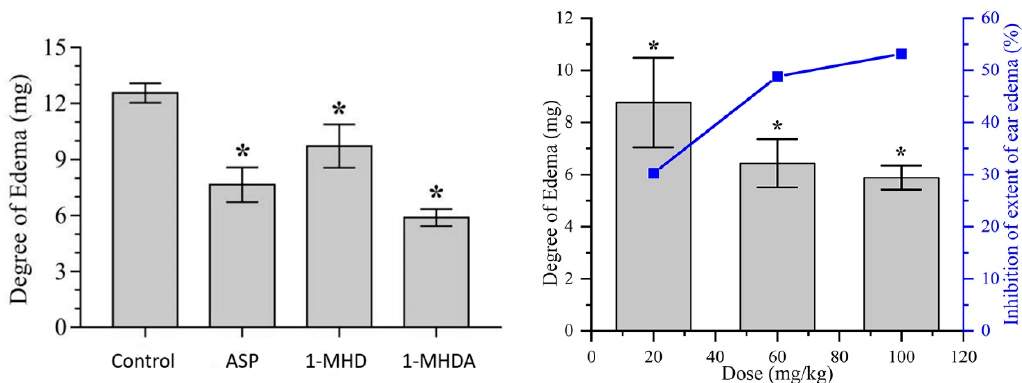
Figure 6. ( a ) The efficacy of different agents at the same dosage 100 mg/Kg. ( b ) the inhibition of 2 at different dosage level. * p < 0.05, for comparison to treated groups with control.